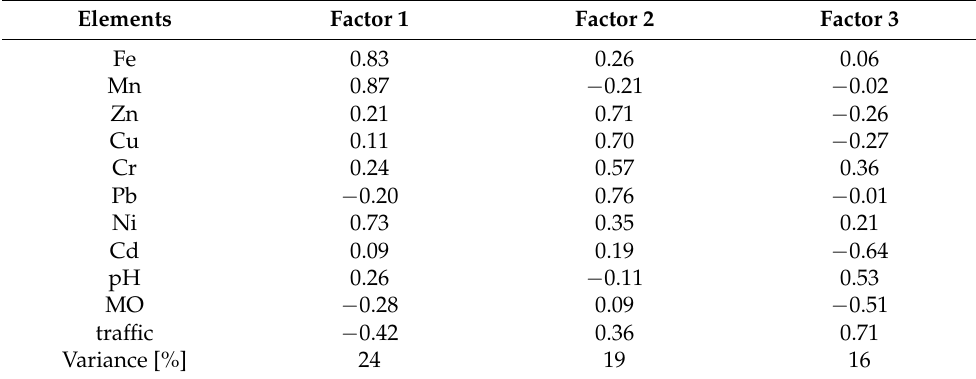
Table 6. Grouping of elements tested based on multivariate analysis (FA).